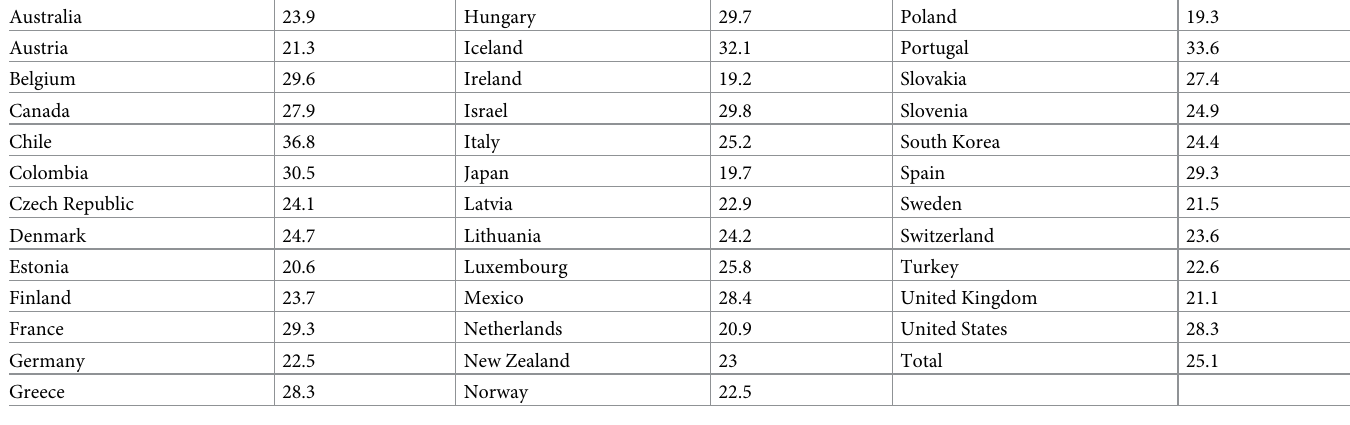
Table 1. Mean pain rates, Gallup World Poll, 2005–2020 (weighted)